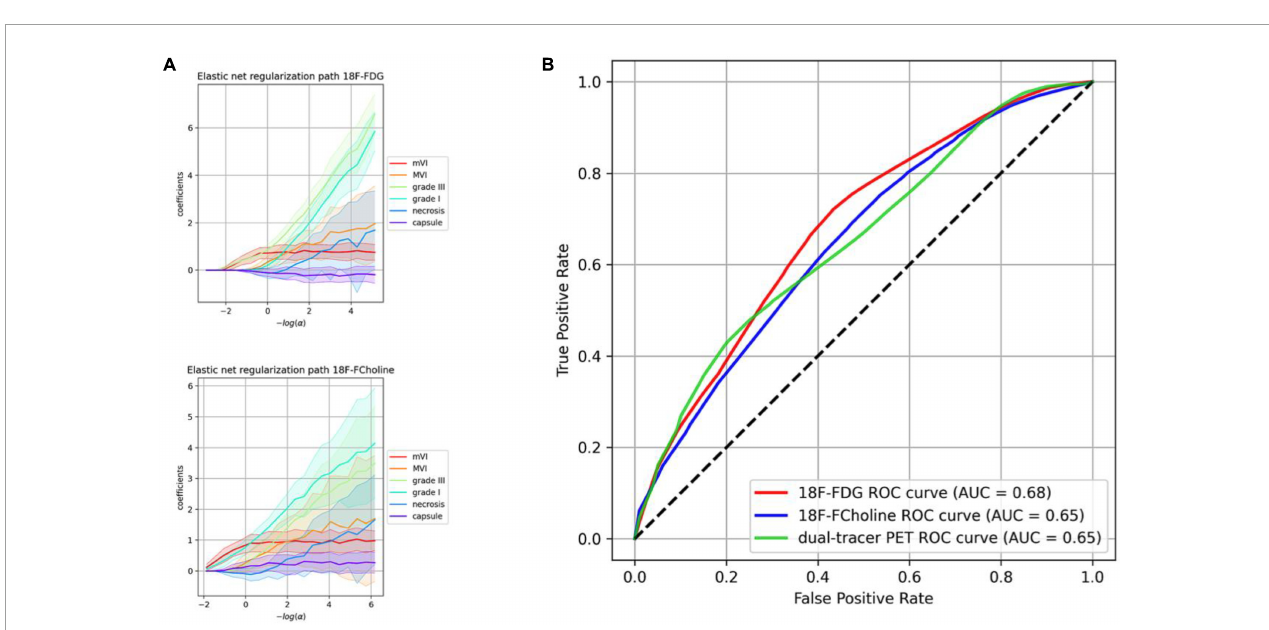
FIGURE6 Regularization paths and model performances including the most relevant histological parameters finally retained. (A) Regularization paths for 18F-fluorodeoxyglucose (18F-FDG) and 18F-choline. The more the penalization decreases (right side), the more the coefficients are scattered. (B) Receiver operating characteristic (ROC) curves of the dimensionality-reduced models’ performance. The ROC curve illustrates the capacity of classifiers to discriminate positive and negative cases at different thresholds (e.g., for the 18F-FDG model and a desired 60% positive rate, the algorithm will yield 38% of false alarms). The random model is represented by identity (dotted line), and the perfect model (with no randomness) is y = 1 on [ 0 , 1 ] .